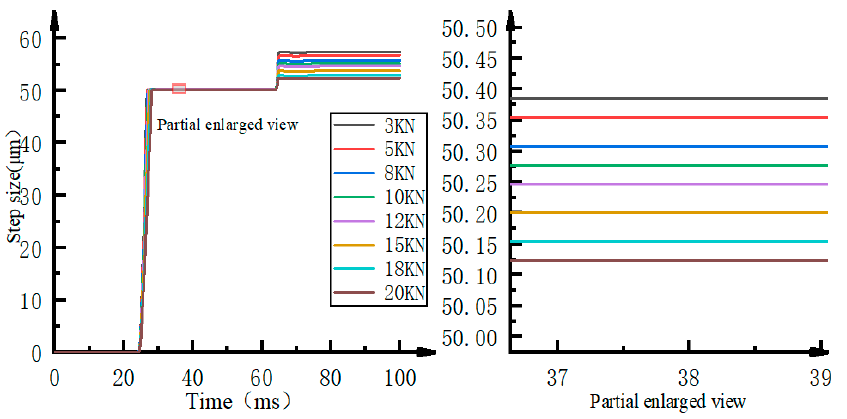
Figure 6. Single-step characteristics of the original stepper